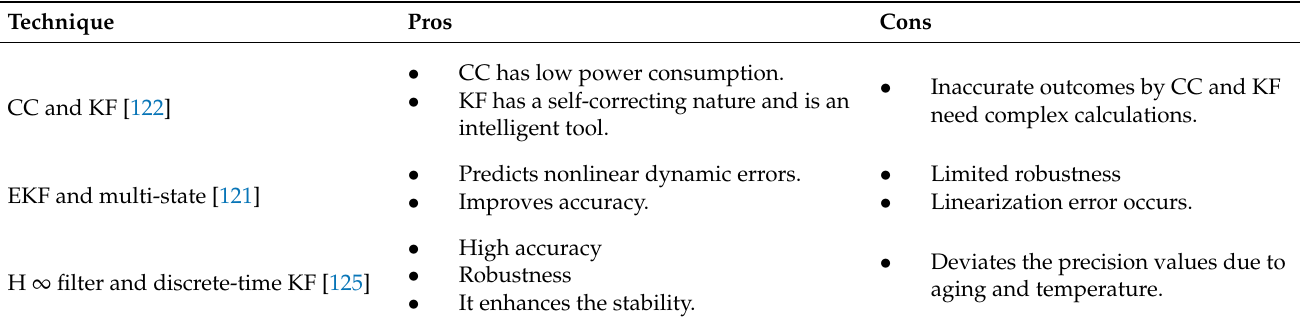
Table 10. Analysis of hybrid SOC estimation